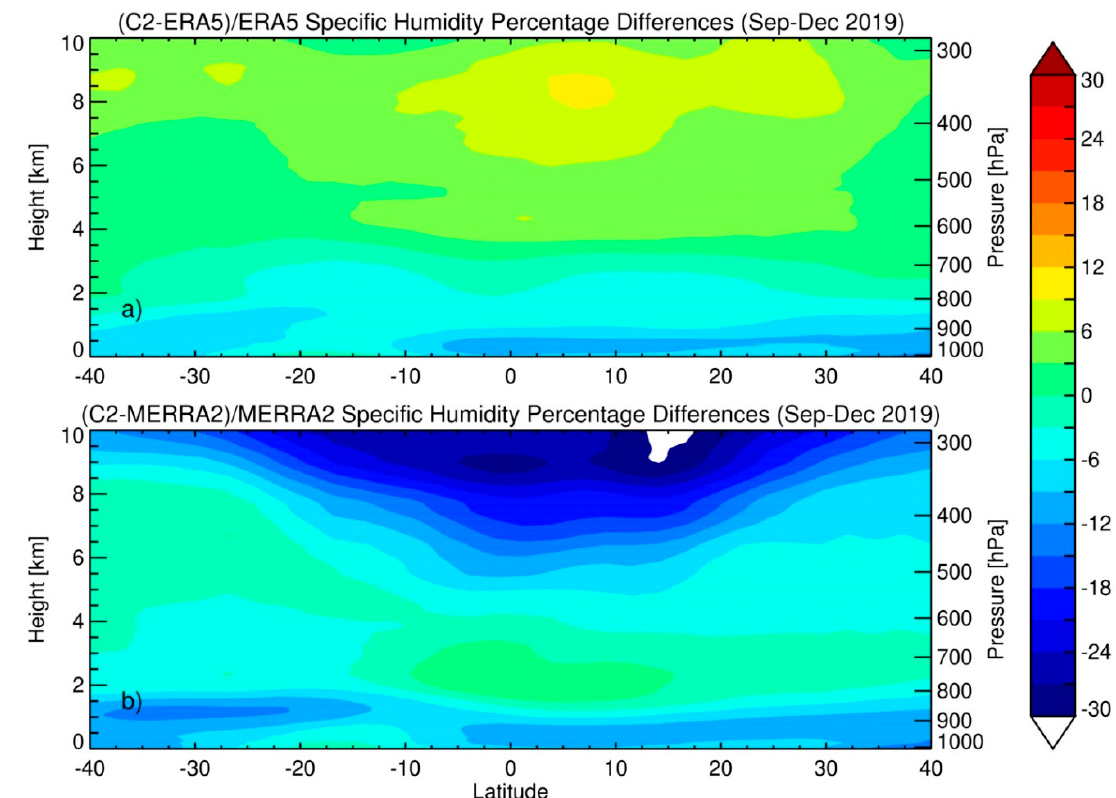
Figure 3. ( a ) C2 and ERA5 zonal specific humidity percentage differences, and ( b ) C2 and MERRA-2 zonal specific humidity percentage differences within 40° N–40° S from September–December 2019.